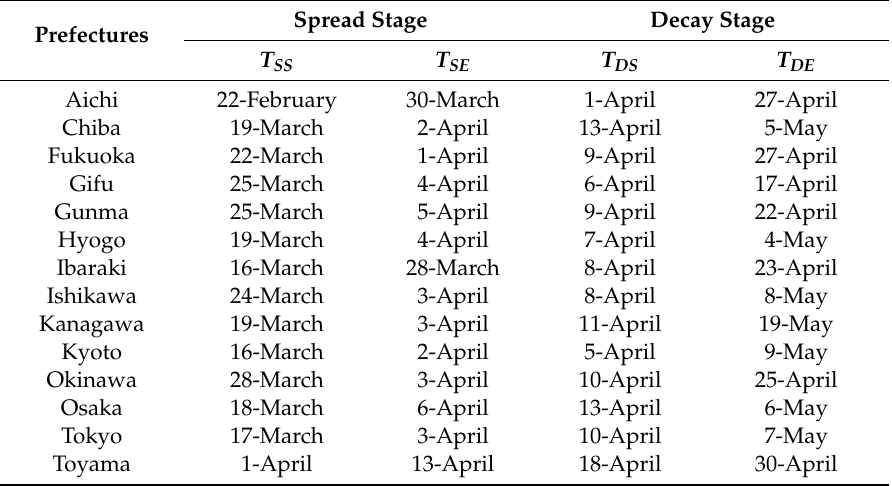
Table 2. Starting and terminating dates of the spread and decay stages of COVID-19 in di ff erent prefectures in Japan. T SS ( T DS ) and T SE ( T DE ) denote the start and end dates for the spread (decay) stages of the